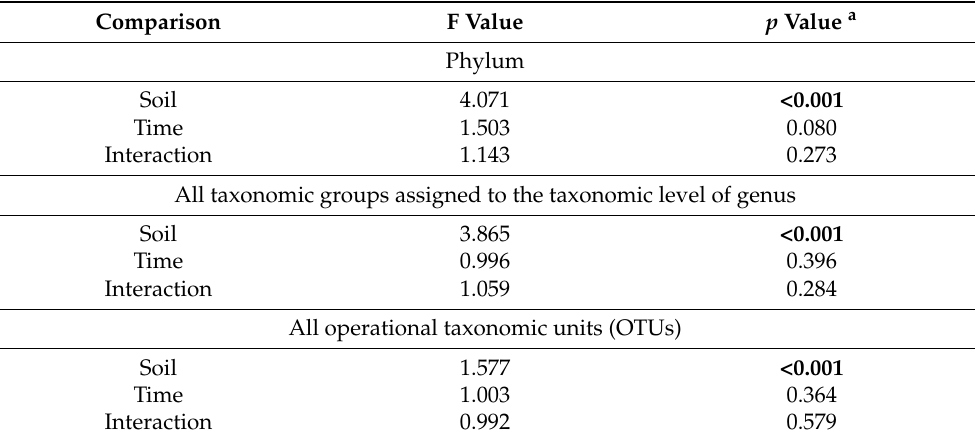
Table 2. The effect of soil (EC 1.9 dS m − 1 , EC 17.3 dS m − 1 and EC 33.4 dS m − 1 ), time (0, 1, 3, 7 and 14 days of aerobic incubation) and their interaction on the soil bacterial community using a perMANOVA analysis with the sequence counts converted to centered log-ratio transformation with ALDEx2 package [39].